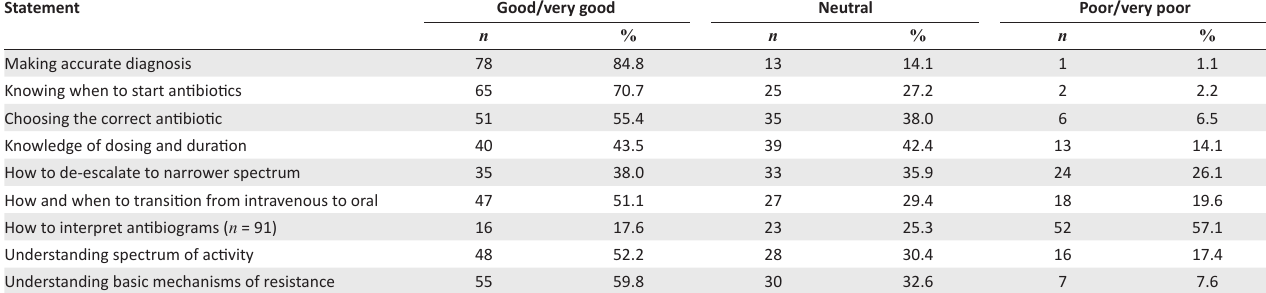
TABLE 2: Interns’ self-reported perceptions regarding their preparedness to prescribe antibiotics ( n = 92).